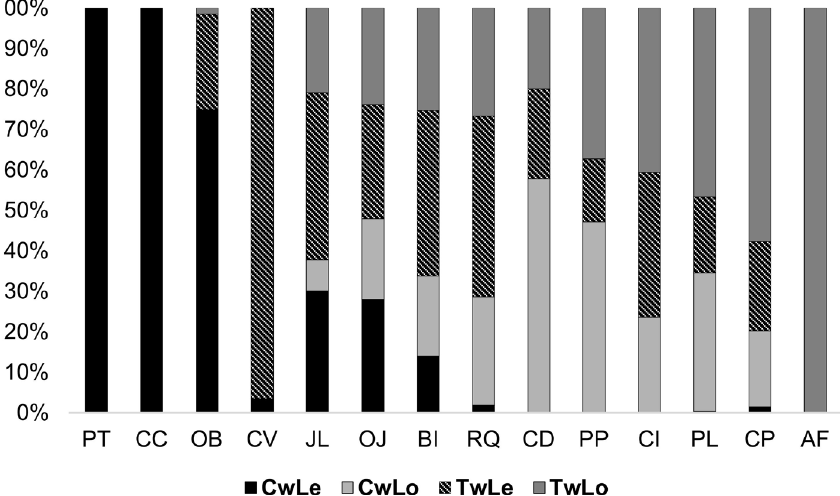
Figure 3. Bar chart showing the distribution of total fish collected of each species within the Sauce Grande River (CwLe = clear water lentic conditions; CwLo = clear water lotic conditions; TwLe = turbid water lentic conditions; TwLo = turbid water lotic conditions). Species are intentionally sorted by means of their spatial distributions to ease the interpretation. Species codes as listed in Table